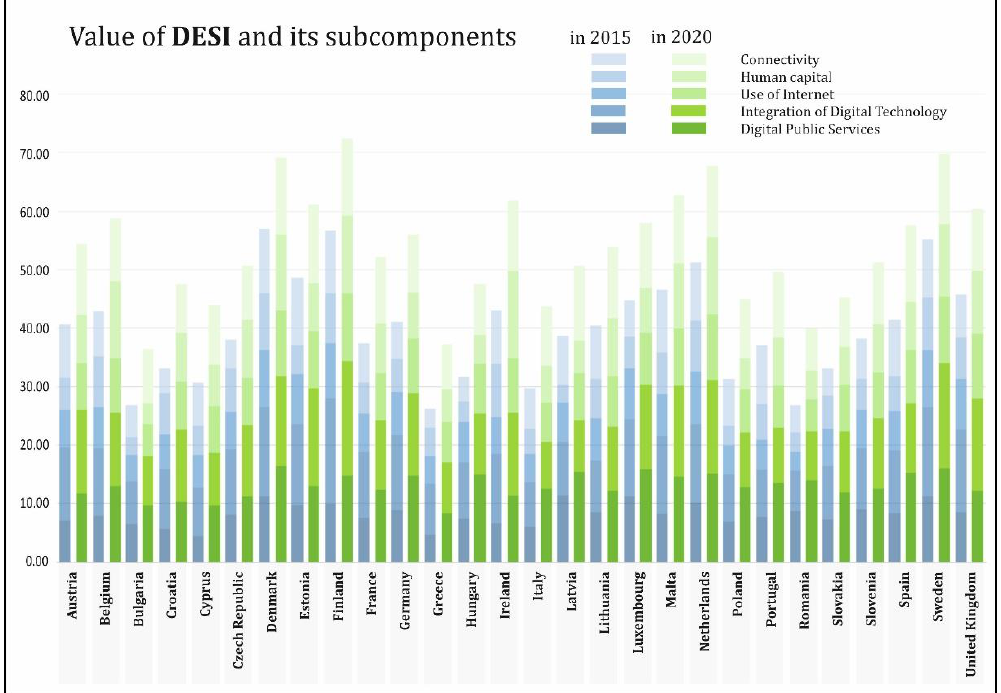
Figure 1. Value of DESI and its subcomponents for EU-28 countries in 2015 and 2020 Source: Our own study based on European Commission data available on the https://digital-agenda-data.eu/ (accessed on 23 October 2020).